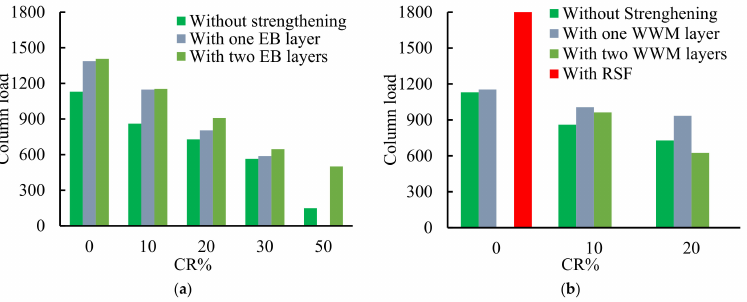
Figure 9. The effect of the EB strengthening, WWM layers, and RSF on the column load. ( a ) Effect of EB layers, ( b ) effect of WWM layers and